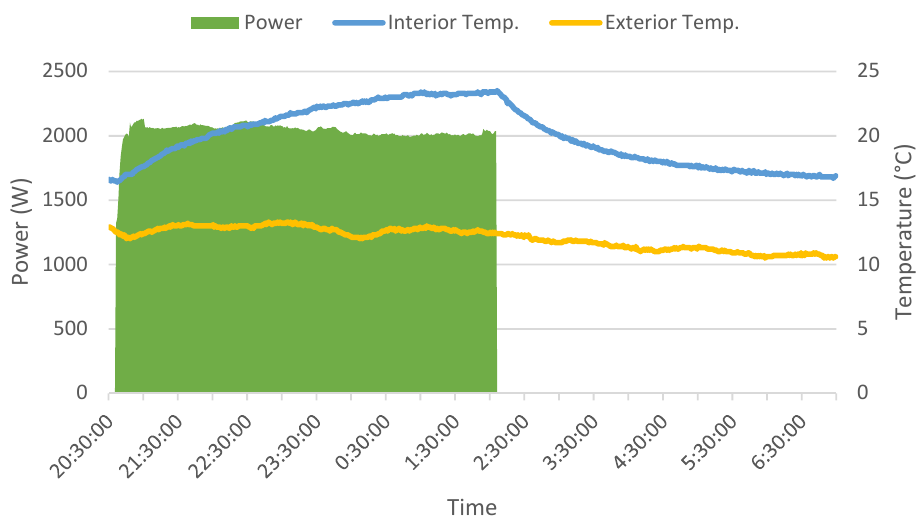
Figure 7. Test A: Power consumption, inside and outside temperature evolution over time since start.